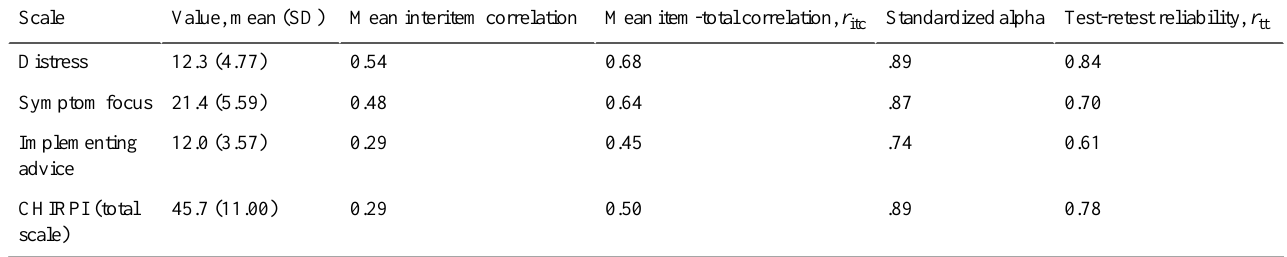
Table 3. Means, standard deviations, interitem correlations, mean item-total correlations, standardized alpha, and test-retest reliability of the Children’s Health Internet Research Parental Inventory (CHIRPI) and its